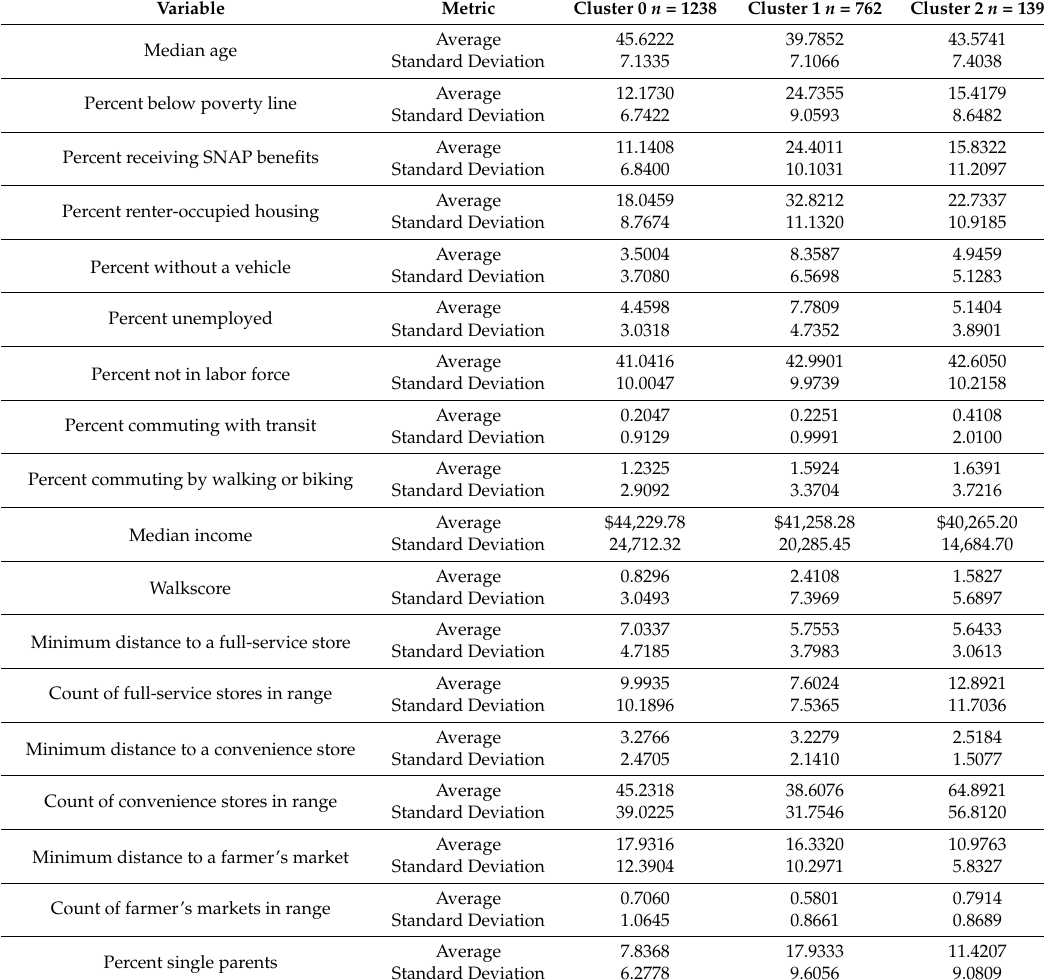
Table 2. Average and standard deviation of variables belonging to three rural clusters.